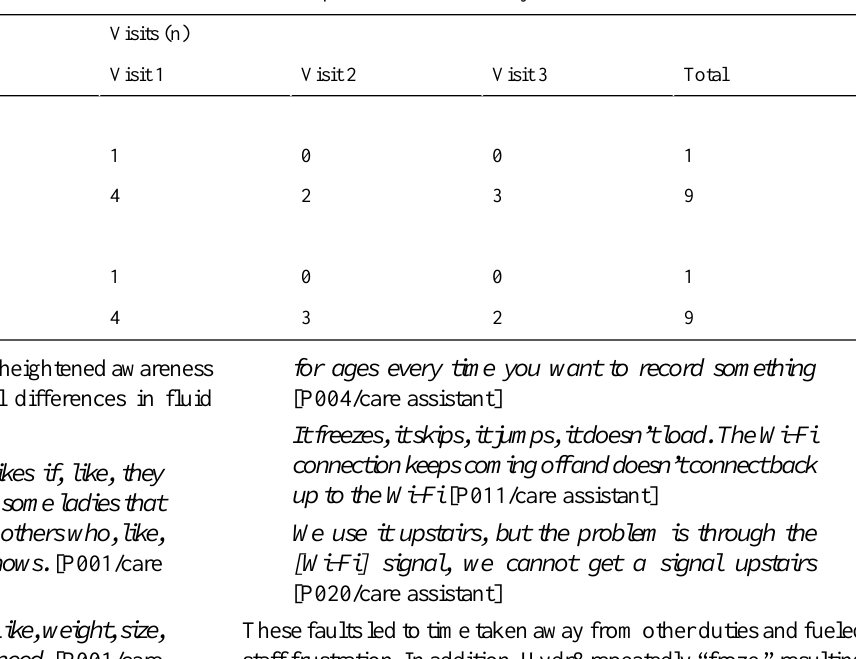
Table 1. Number of observations and interviews conducted over the 3 data collection points for the case-study sites.